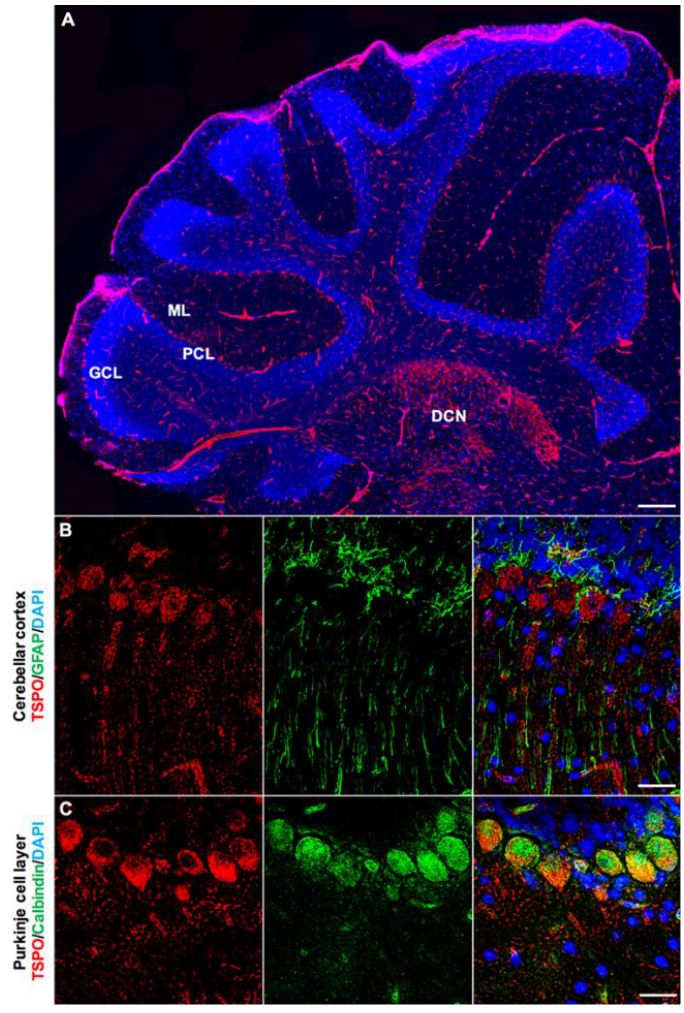
Figure 6. TSPO expression in the cerebellum of the normal mouse brain. ( A ) Sagittal view of TSPO expression (red) across the cerebellar region. Structural features of the region highlighted with DAPI (blue) to delineate cerebellar cortical layers. TSPO is expressed in the Purkinje cell layer and the molecular layer. Also of note is salient TSPO expression in the deep cerebellar nuclei. ( B ) Immunofluorescence staining with TSPO (red) and GFAP (green) in the Purkinje cell layer. TSPO is clearly discernible in Purkinje cells and the molecular layer, which contains dendritic projections. GFAP+ astrocytes/radial glia are also found in this region, though do not express TSPO. ( C ) Calbindin (green) and TSPO (red) immunostaining confirms significant colocalization of TSPO in the perinuclear region of Purkinje cells. Scale bars = 300 µm for ( A ), 20 µm for ( B , C ). ML = molecular layer, PCL = Purkinje cell layer, GCL = granule cell layer, DCN = deep cerebellar nuclei.